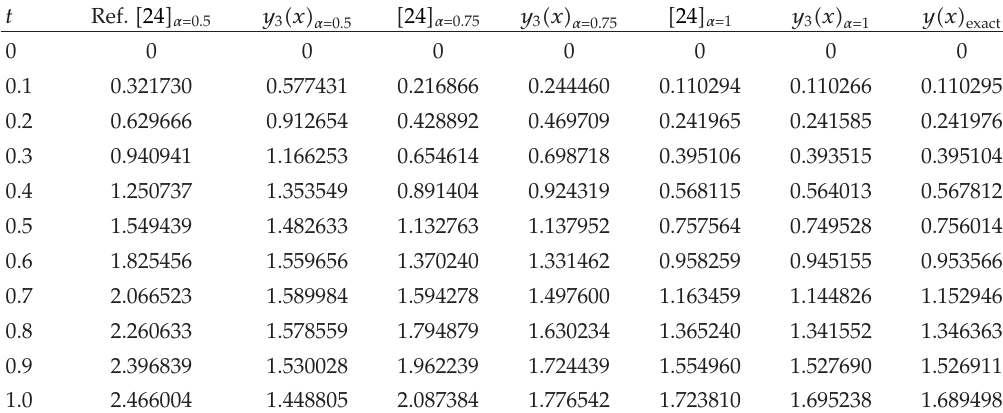
Table 2: Approximate solutions for (cid:3) 4.11 (cid:4)